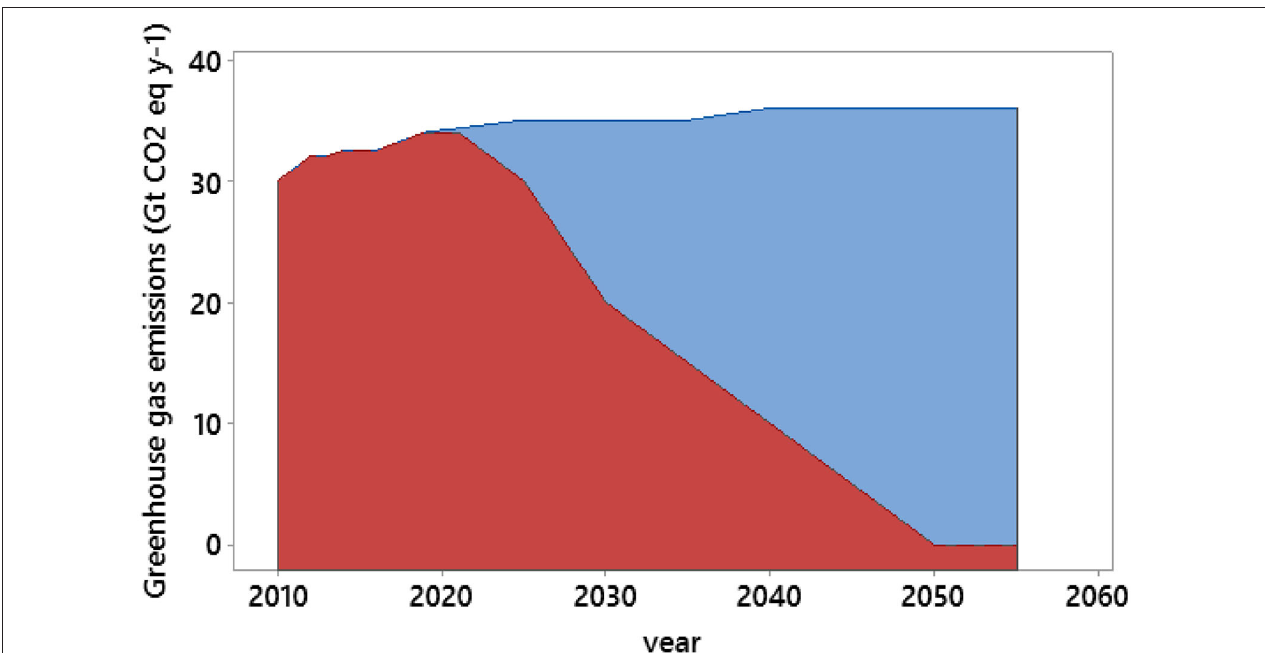
FIGURE 1 | This is a graph of projected emissions to 2055. The area under the red curve is the IPCC SR1.5 low-energy demand–projected net annual emission pathway to keep global warming below 1.5 ◦ C, reaching net zero by 2050. The area in blue is the difference between the projected emissions from the IEA for currently stated policy scenario and the desired net zero pathway. This is the potential CCS requirement to achieve net zero by 2050.